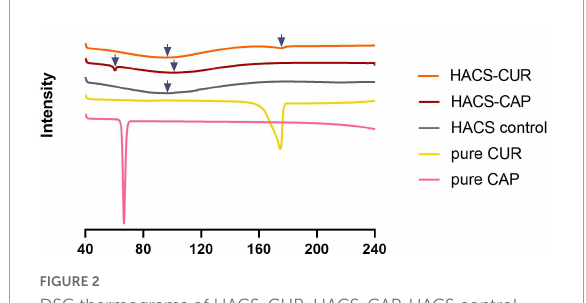
FIGURE2 DSC thermograms of HACS-CUR, HACS-CAP, HACS control (empty), pure CUR and pure